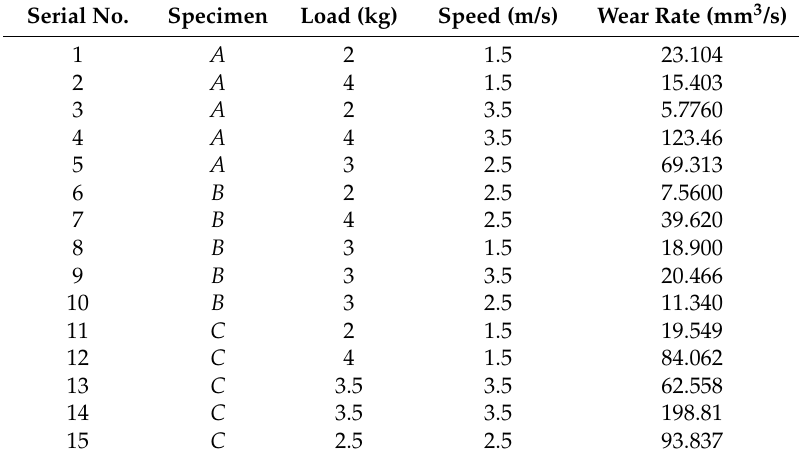
Table 2. Wear rates of the proposed hybrid MMC for different specimens.